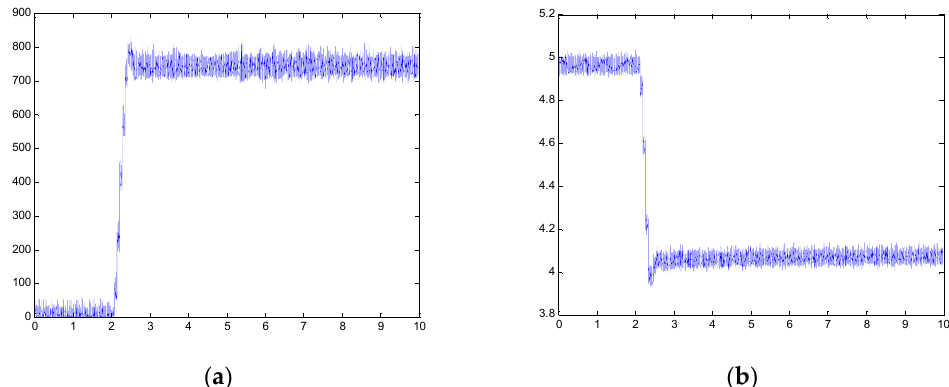
Figure 7. Configuration of the proposed sliding mode control. ( a ) The traditional SMC; ( b ) the proposed SMC.